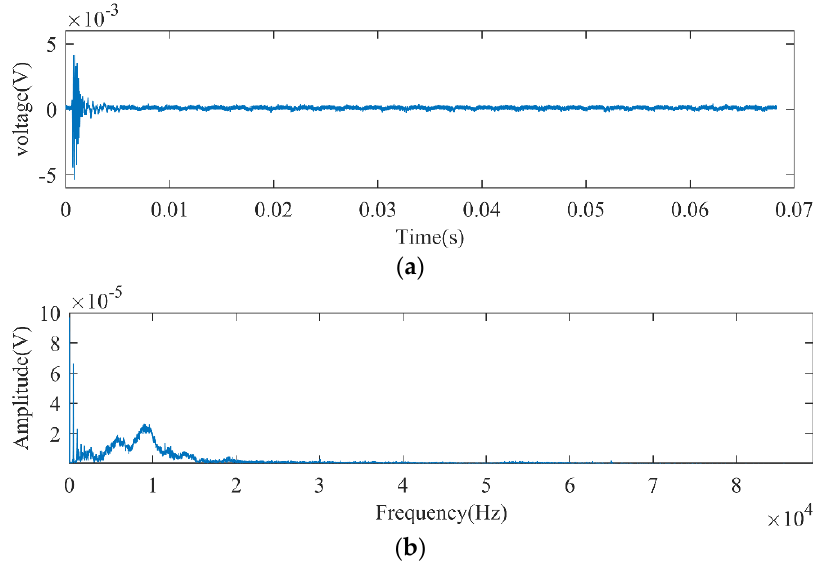
Figure 21. Time domain and frequency domain waveform diagram of noise signal of Caihong Bridge. ( a ) Signal time domain diagram; ( b ) signal frequency domain diagram.